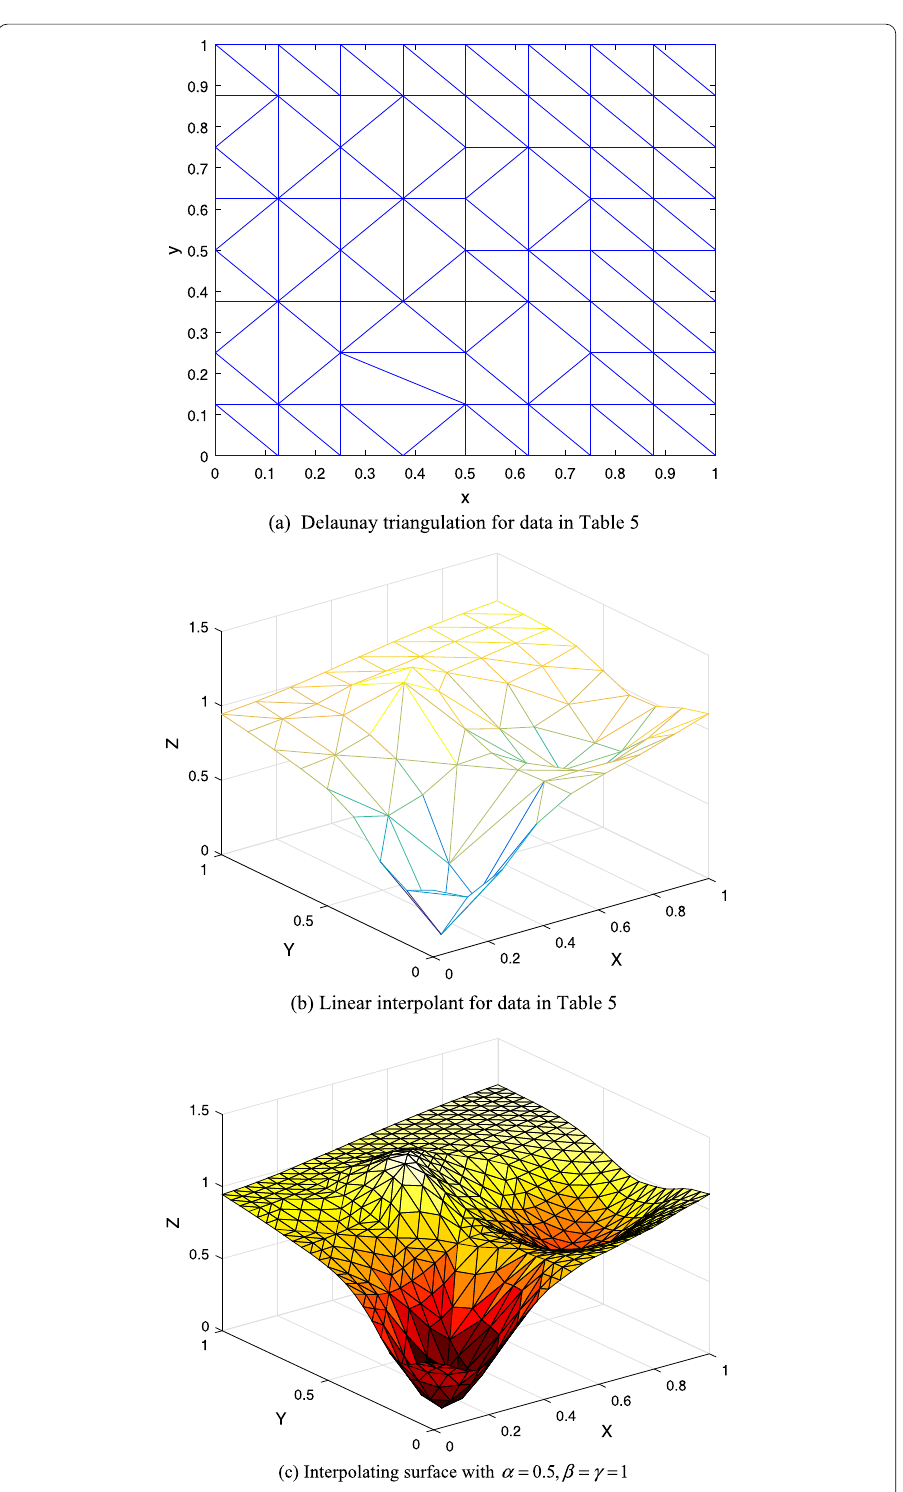
Figure 11 Interpolating scattered data surface for irregular